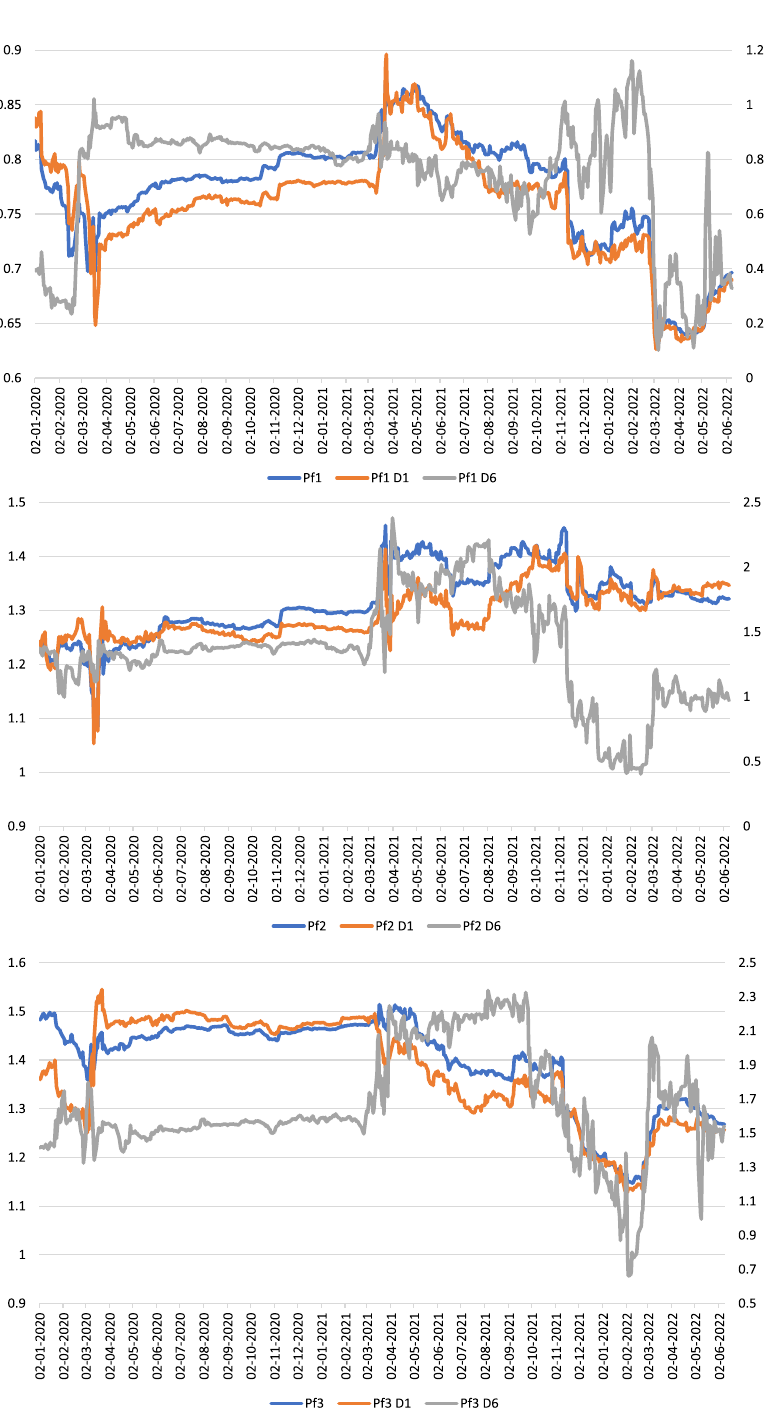
Fig. 2 Time–frequency-varying betas of portfolios in the crisis